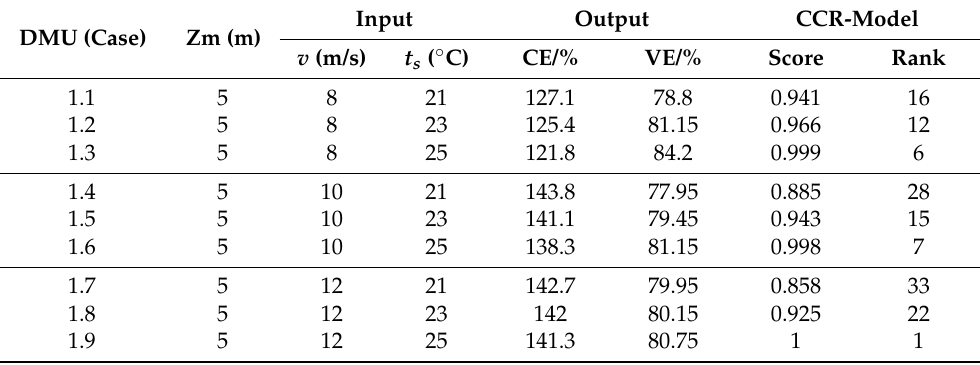
Table 7. CCR efficiency scores and ranks of 45